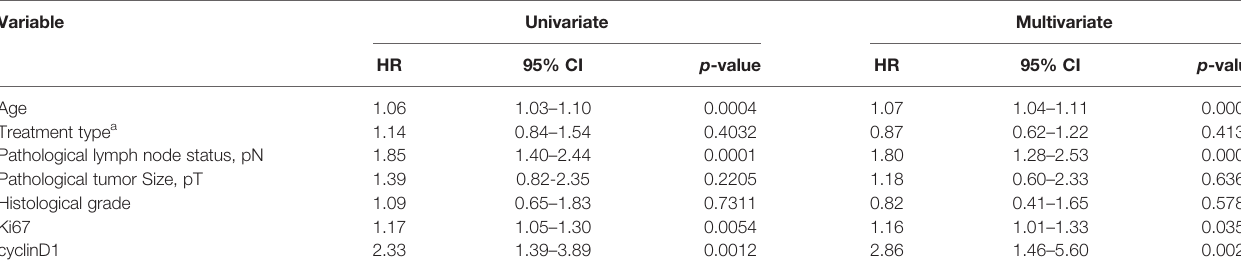
TABLE 2 | Univariate and multivariate Cox regression of overall survival (OS) of Ki67 and cyclinD1 values. Variable